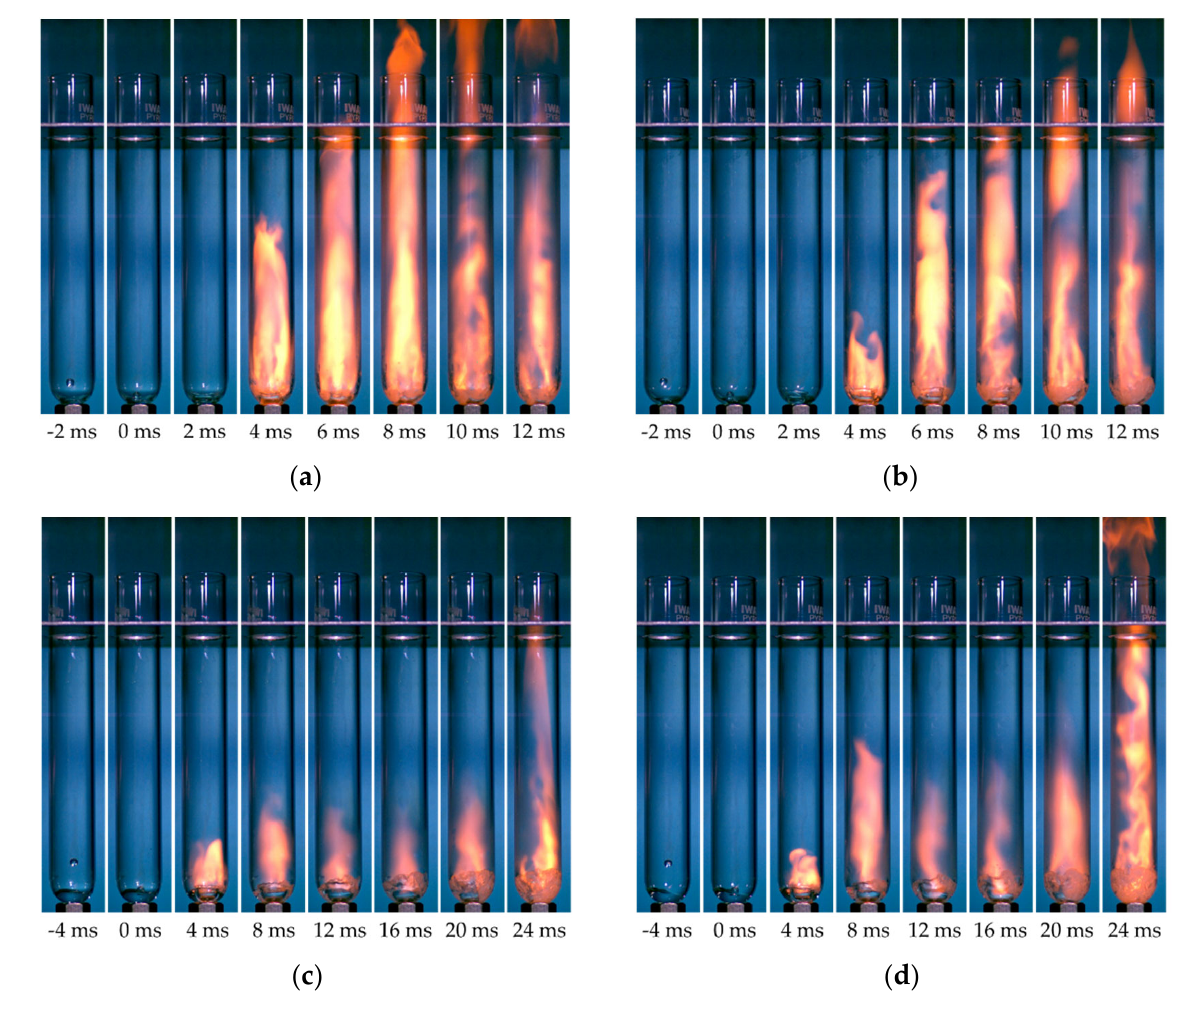
Figure 4. High ‐ speed camera images of drop test (( a ) MR = 4.9, ( b ) MR = 8.2, ( c ) MR = 16.4, ( d ) MR =